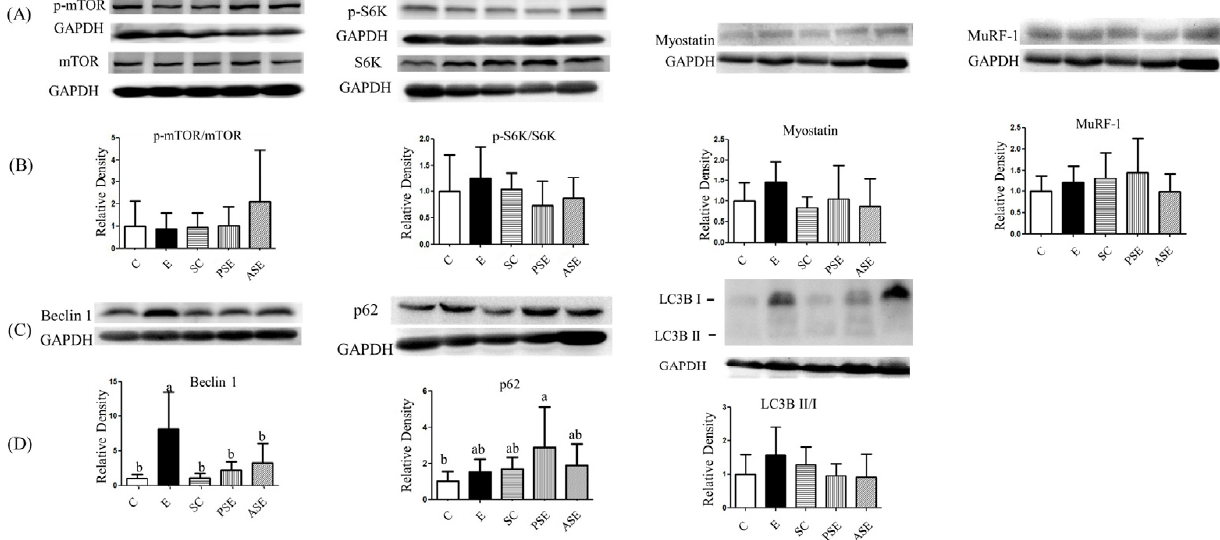
Figure 9. Effects of synbiotics on the related factors of muscle protein synthesis and degradation in rats with chronic ethanol feeding. ( A ) Western blot analysis of p-mTOR/mTOR, p-S6K/S6K, myostatin and MuRF-1 protein expressions. Glyceraldehyde 3-phosphate dehydrogenase (GAPDH) was used as an internal control. ( B ) Quantitative analysis of protein levels and the ratio of each to the internal control was calculated by setting the value of the mean of the C group to 1. ( C ) Western blot analysis of beclin-1, p62 and LC3BII/I protein expressions. Glyceraldehyde 3-phosphate dehydrogenase (GAPDH) was used as an internal control. ( D ) Quantitative analysis of protein levels and the ratio of each to the internal control was calculated by setting the value of the mean of the C group to 1. Bars are the mean ± standard deviation ( n = 6). Different letters indicate a significant difference at p < 0.05 by a one-way ANOVA with Duncan’s post-hoc test.